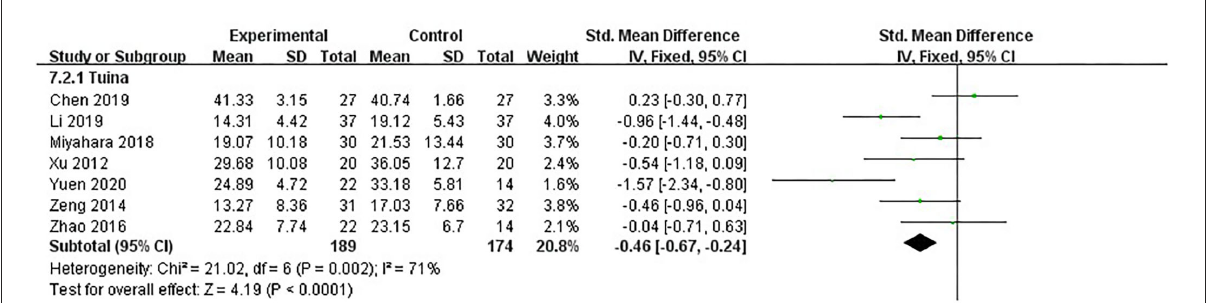
FIGURE5 Comparison 2: therapeutic massage vs. control. Outcome 2: UPDRS-III.